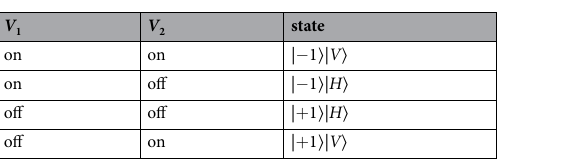
Table 3. Designed switch for generating desired optical states when the input state of the modulator is | + 1 〉 |H 〉